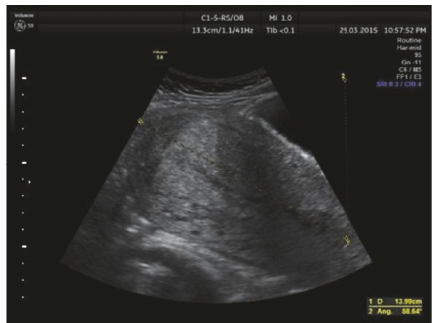
Figure 5: Uterine angle (in degrees) measurement in relation to the longitudinal axis of the